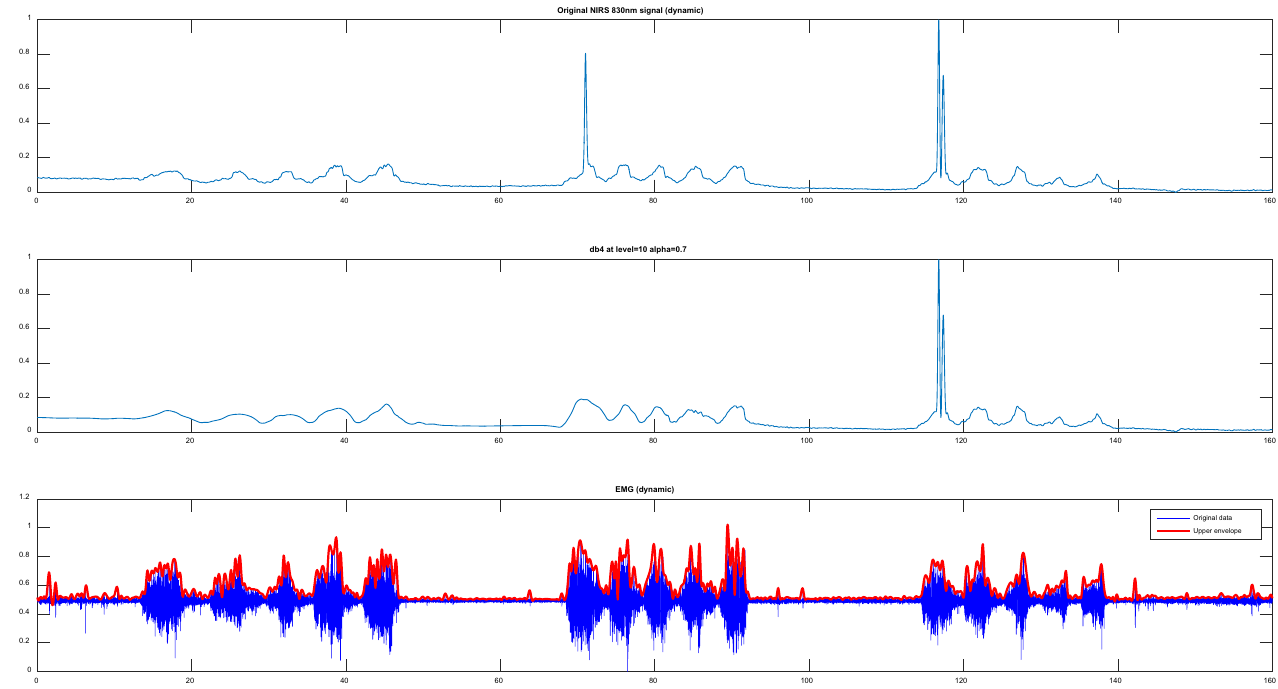
Fig. 7. Applying motion artifact removal to dynamic experiment. Top: original NIRS signal, middle: NIRS signal after removing motion artifact, bottom: EMG